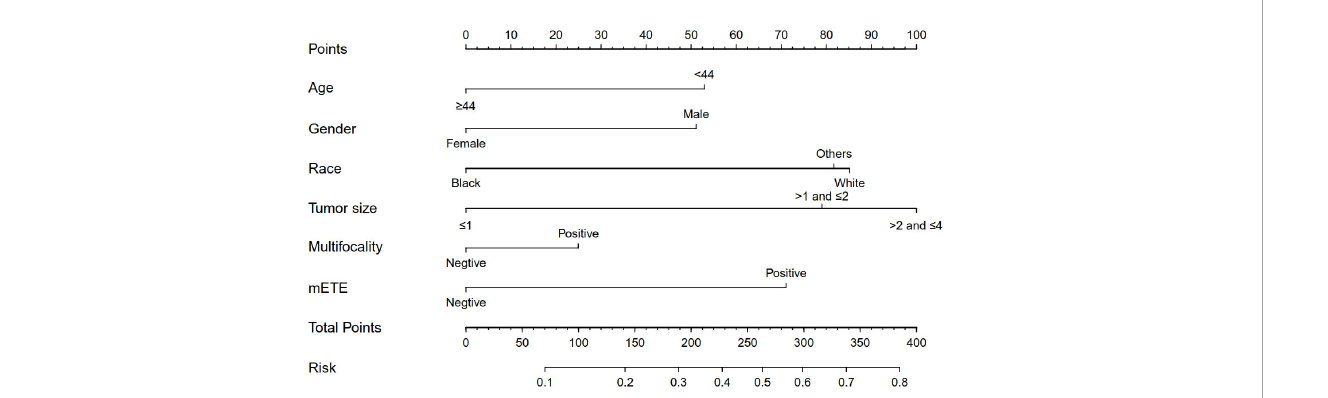
FIGURE 2 Clinicopathological characteristics-based nomogram used for prediction of CLNM in T1-T2 PTC patients with no LLNM. Other, Asian/Paci fi c Islander and American Indian/Alaska Native; mETE, minimal extrathyroidal extension; CLNM, central lymph node metastasis; LLNM, lateral lymph node metastases; Age (years); Tumor size